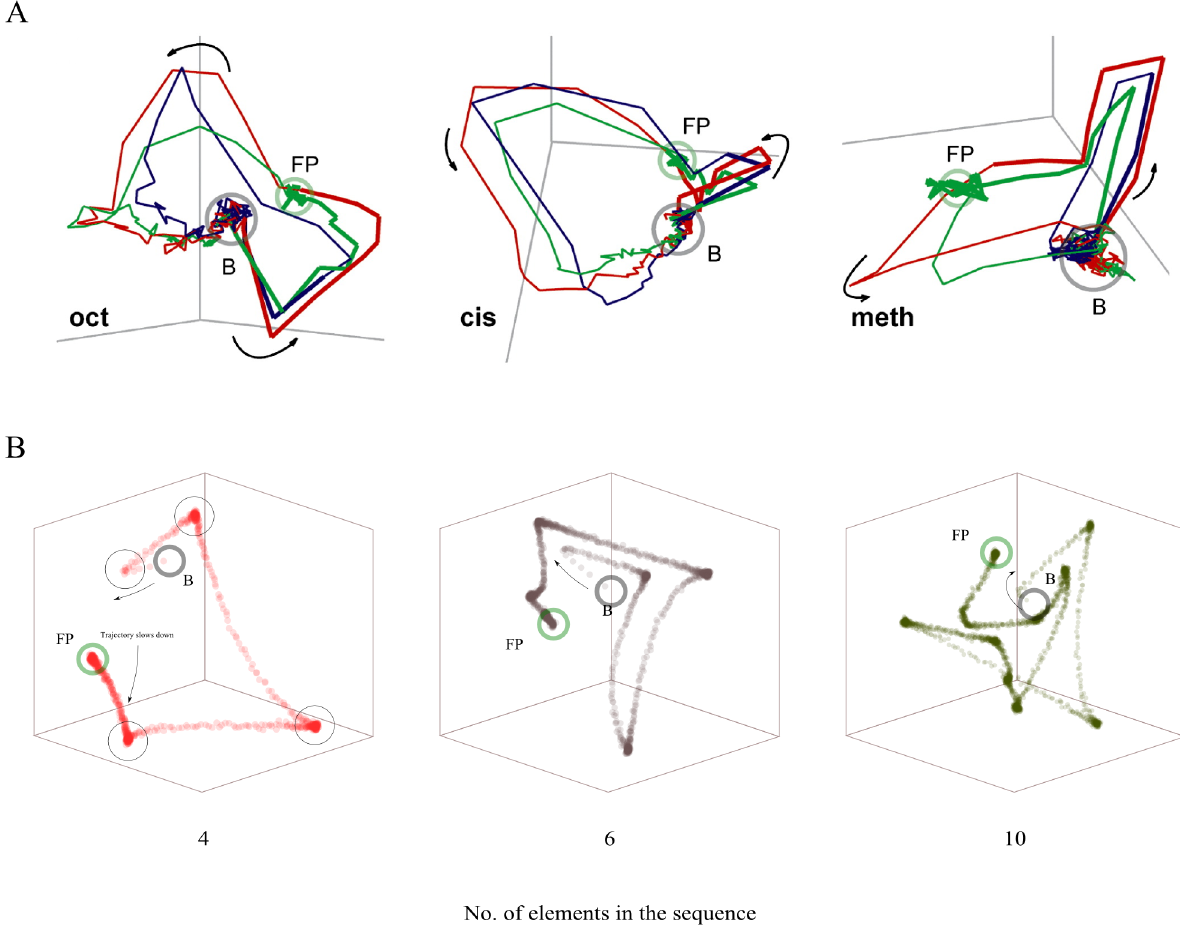
Fig 11. Dimension reduction of the PN response to a stimulus. (A) Data as presented in [7] showing the trajectories in the first three components of principal component analysis for three different odors (different plots) and three stimulus durations for each odor (blue, red and green for 0.3s, 1s and 3s, respectively). The dynamic phase of activity lies between baseline activity (represented by B) and the fixed point (FP), where a number of turning points can be seen, between 2 and 4 for different cases. (B) First three elements of principal components analysis of the data obtained with the proposed model of the 30 PNs during the first phase of the full response, for different number of clusters in a sequence (4, 6 and 10 clusters). The number of elements equals the number of sharp turning points in the trajectory (big circles in the left-most plot). Around each turning point, the data points agglomerate, reflecting the period in which a cluster remains active. Since we used data from only the onset sequential phase, the trajectories we present are not closed as in experimental data where the data acquisition is done up until the system returns to baseline, a few seconds after odor offset. The points B and FB, as before, represent the baseline (at odor onset) and the fixed point (end of onset sequential